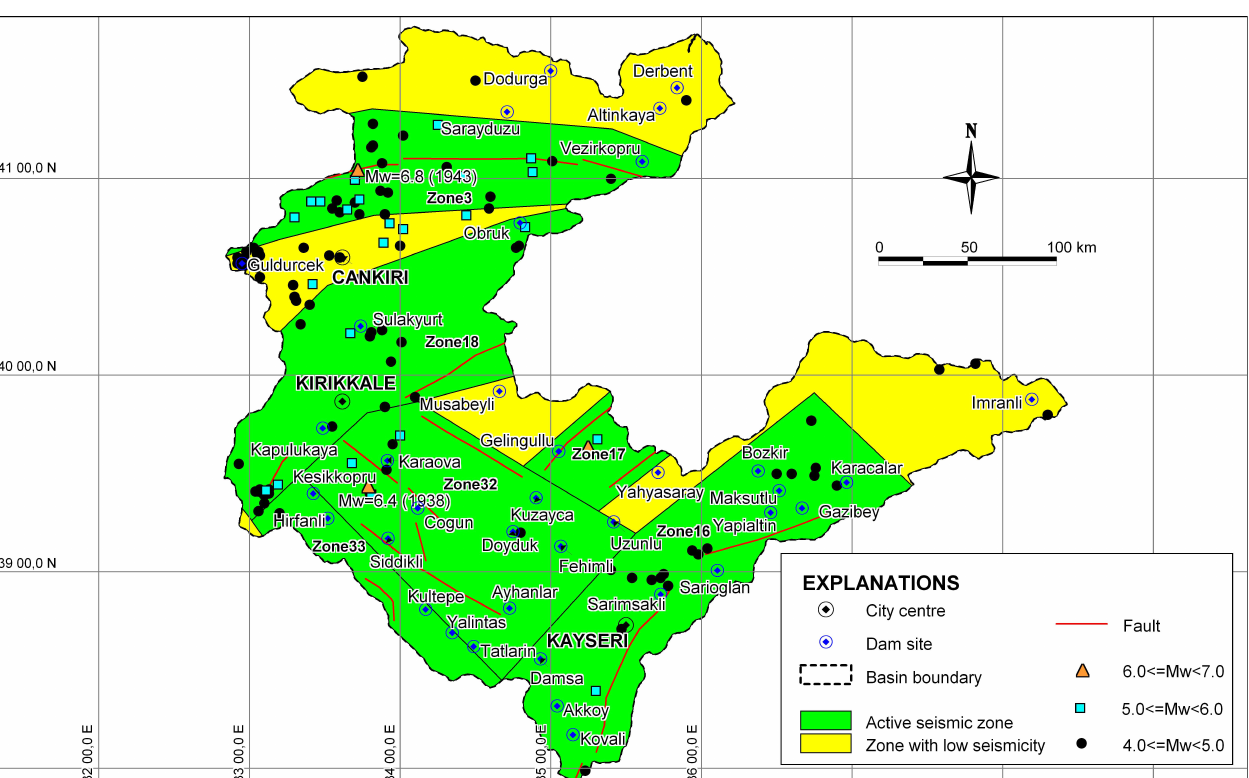
Fig. 3. Seismic zones and earthquakes occurred in the basin within last